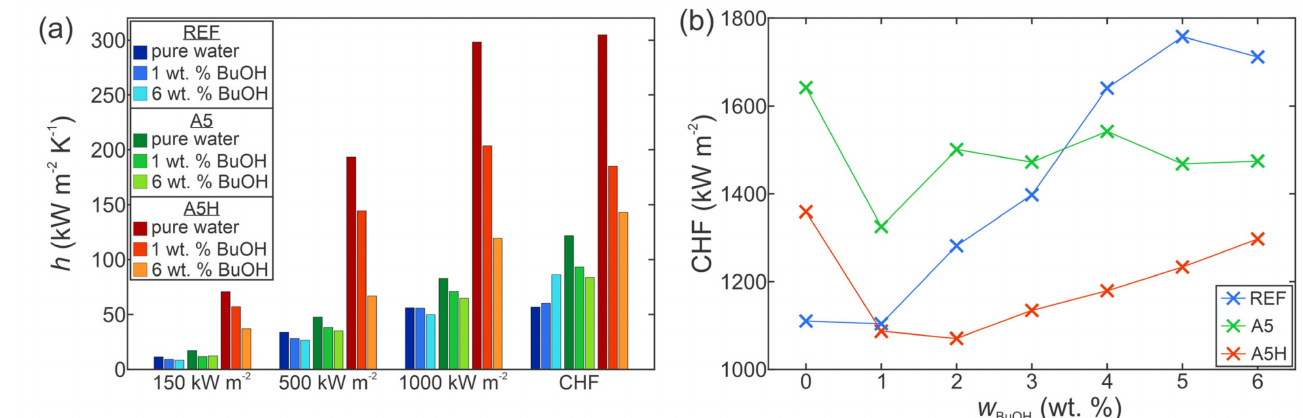
Figure 8. Comparison of heat transfer coefficients on surfaces REF, A5 and A5H for boiling of pure water, 1 wt.% or 6 wt.% 1-butanol mixture ( a ) and the relationship between the CHF value and mass concentration of 1-butanol for the same surfaces ( b